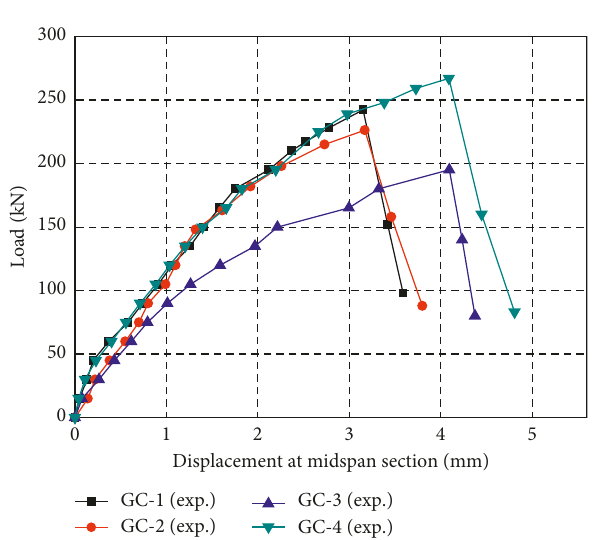
Figure 8: Comparison of experimental load-deflection curves at midspan cross